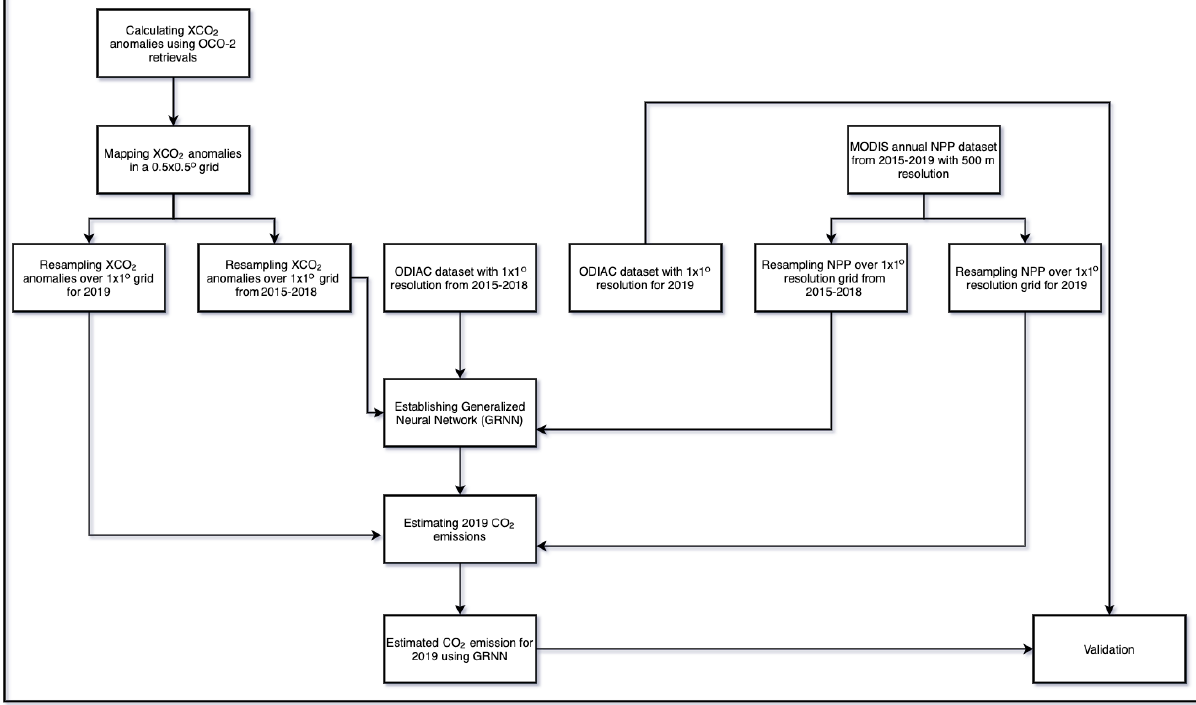
Figure 1. Flowchart explaining the steps involved in estimating the anthropogenic CO 2 emissions using MODIS NPP and OCO-2 XCO 2 retrievals.